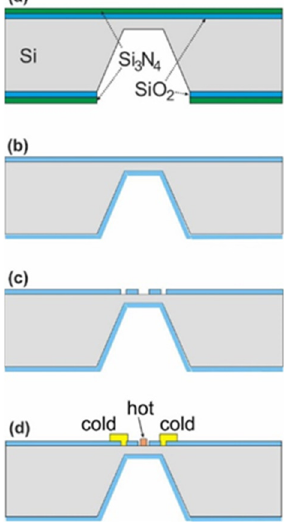
Figure 1. Cross sections at subsequent stages of fabrication of the thermoelectric detector before FIB treatment: ( a ) wafer oxidation, Si 3 N 4 deposition, and silicon etching in KOH; ( b ) silicon nitride mask removal and Si membrane oxidation; ( c ) etching of contacts to the silicon; ( d ) sputter deposition of Al (cold contact to Si) and Pt metallization as a hot thermocouple. The sample structure of the detector is shown in the SEM image in Figure 2.